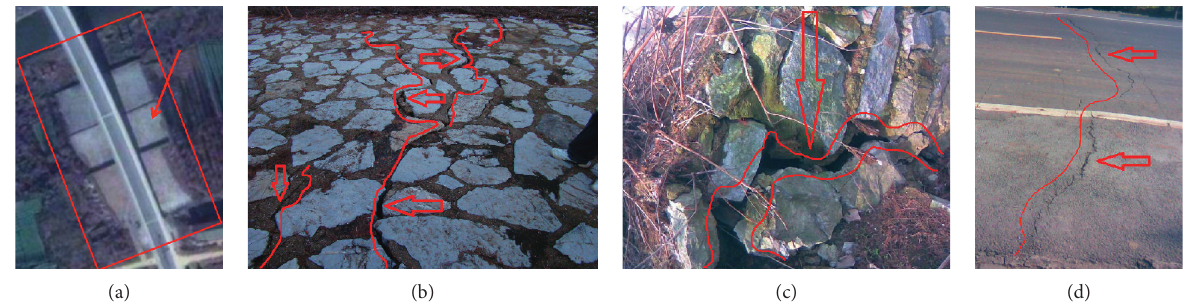
Figure 2: (a) Layout of the slope (plan view); (b, c) cracks in the stone masonry; (d) thoroughgoing cracks in the road.